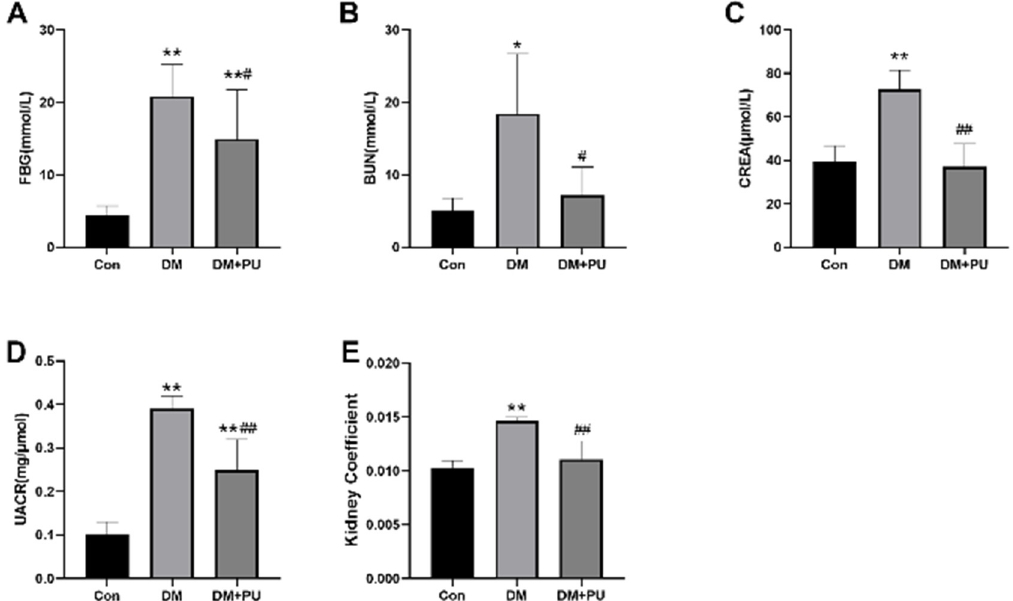
Figure 1. E ff ects of PU on the HFD / STZ-induced diabetic mice model after 8 weeks. ( A ) Fasting blood glucose intragastric administration. ( B ) Blood urea nitrogen after 8 weeks’ intragastric administration. ( C ) Serum creatinine after 8 weeks’ intragastric administration. ( D ) Urine albumin-creatine ratio after 8 weeks’ intragastric administration. ( E ) Kidney coe ffi cient of the mice after 8 weeks’ intragastric administration. * p < 0.05 vs. control (Con) group; ** p < 0.01 vs. Con group; # p < 0.05 vs. diabetes mellitus (DM) group; ## p < 0.01 vs. DM group; n = 8.